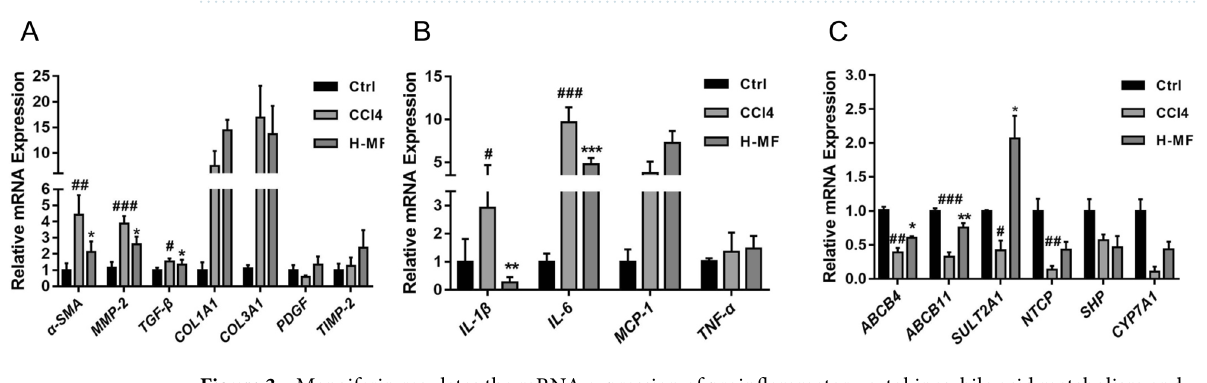
Figure 3. Mangiferin regulates the mRNA expression of proinflammatory cytokines, bile acid metabolism and pro-fibrotic related genes. Real time quantitative PCR were performed to detect the mRNA expression. ( A ) The mRNA expression levels of α-SMA, MMP2, TGF-β, COL1A1, COL3A1, PDGF and TIMP-2. ( B ) The mRNA expression levels of IL-1β, IL-6, MCP-1 and TNF-α. ( C ) The mRNA expression levels of ABCB4, ABCB11, SULT2A1, NTCP, SHP and CYP7A1. Date are presented as means ± S.E.M. (n = 8). # p < 0.05, ## p < 0.01 and ### p < 0.001, compared with control group. * p < 0.05, ** p < 0.01 and *** p < 0.001, compared with CCl4 group. Ctrl, control group; CCl4, carbon tetrachloride treated group; L-MF, low dose of mangiferin (50 mg/kg); H-MF, high dose of mangiferin (100